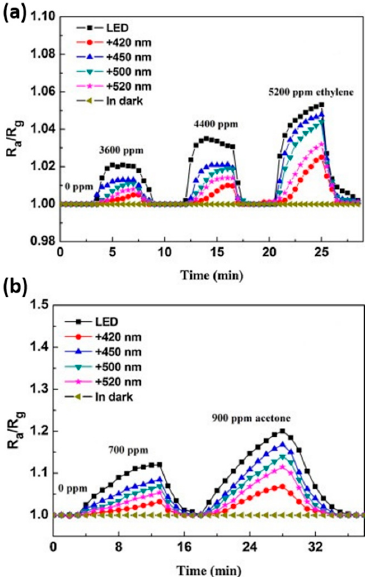
Figure 4. Sensing response of ZnO sensor to different concentrations of ( a ) ethylene and ( b ) acetone in air atmosphere in dark or under visible-light irradiation of different wavelengths. Reproduced with permission from [37]. Micromachines 2017 , 8 , 333